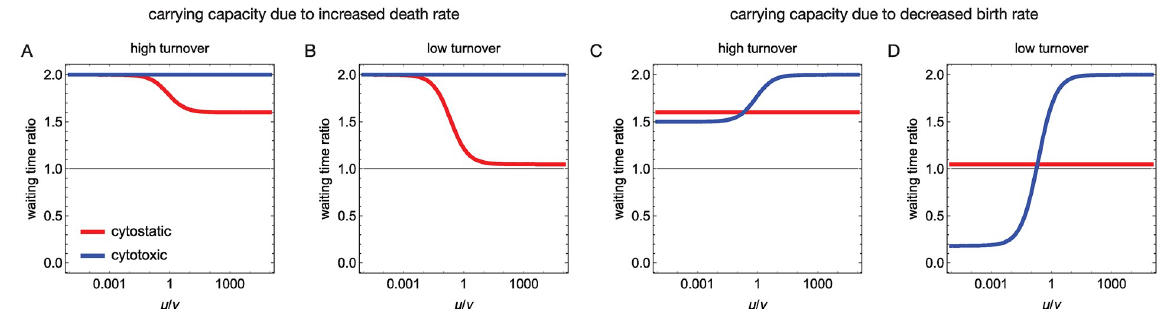
Fig 2. Case primary tumour does not decline. Ratios of expected waiting times until progression of cytostatic (red, target β 0 ) and cytotoxic (blue, target δ 0 ) compared to no therapy, under different migration μ and driver mutation rates γ from Eqs 2–6; black this line denotes equally long waiting times (i.e the ratio = 1). High turnover cases have ( β 0 = 1.0, δ 0 = 0.6) and low turnover cases ( β 0 = 0.42, δ 0 = 0.02), treatment strength Δ = 0.2. A,B High and low turnover cases where cell competition at the primary tumour is due to increasing death rates. Both treatments are better than no treatment, and cytotoxic (blue) is superior to cytostatic (red) treatment. C High turnover case where cell competition at the primary tumour is due to decreasing birth rates. Both treatments are better than no treatment and cytostatic treatment is better than cytotoxic when μ / γ < ( β 0 − δ 0 − Δ ). D Low turnover case where cell competition at the primary tumour is due to decreasing birth rates. Cytotoxic treatment is better than cytostatic treatment when μ / γ > ( β 0 − δ 0 − Δ ) and better than no treatment if μ / γ > ( β 0 − 2 δ 0 − Δ ). Cytostatic treatment is always better than no treatment. For each case, at least one of the treatments is better than no